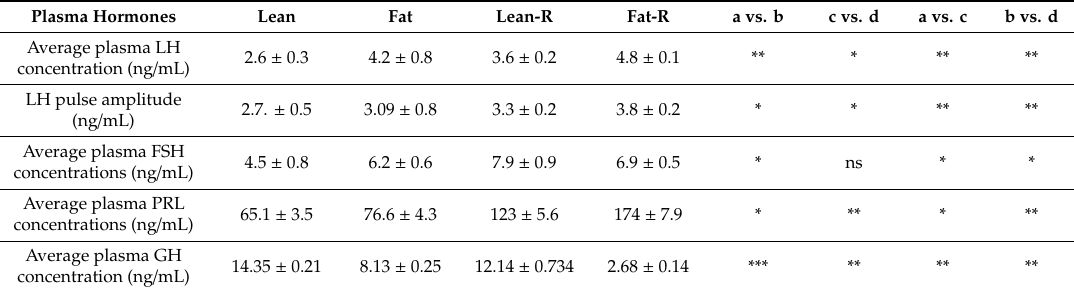
Table 2. Plasma concentrations (mean ± SEM) of hormones (LH, FSH, PRL and GH) ) in nontreated (Lean and Fat) animals and animals treated with recombinant bovine resistin (Lean-R [Lean-Resistin treated] and Fat-R [Fat-Resistin treated]; n = 5) after alter 5-month with body weight alternation ( n = 5 per group). Plasma Hormones Lean Average plasma LH concentration (ng / mL)